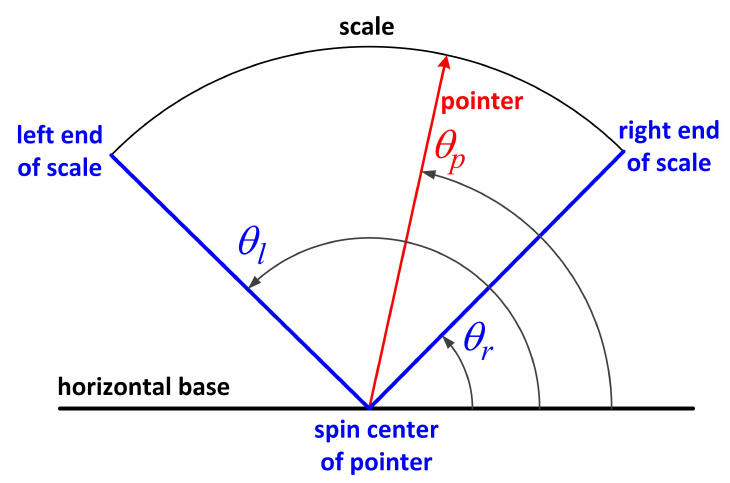
Figure 5. Relationship between the pointer indicated by θ p and the scale in the R IM of the A-meter where the scale is confined within the range from θ r to θ l